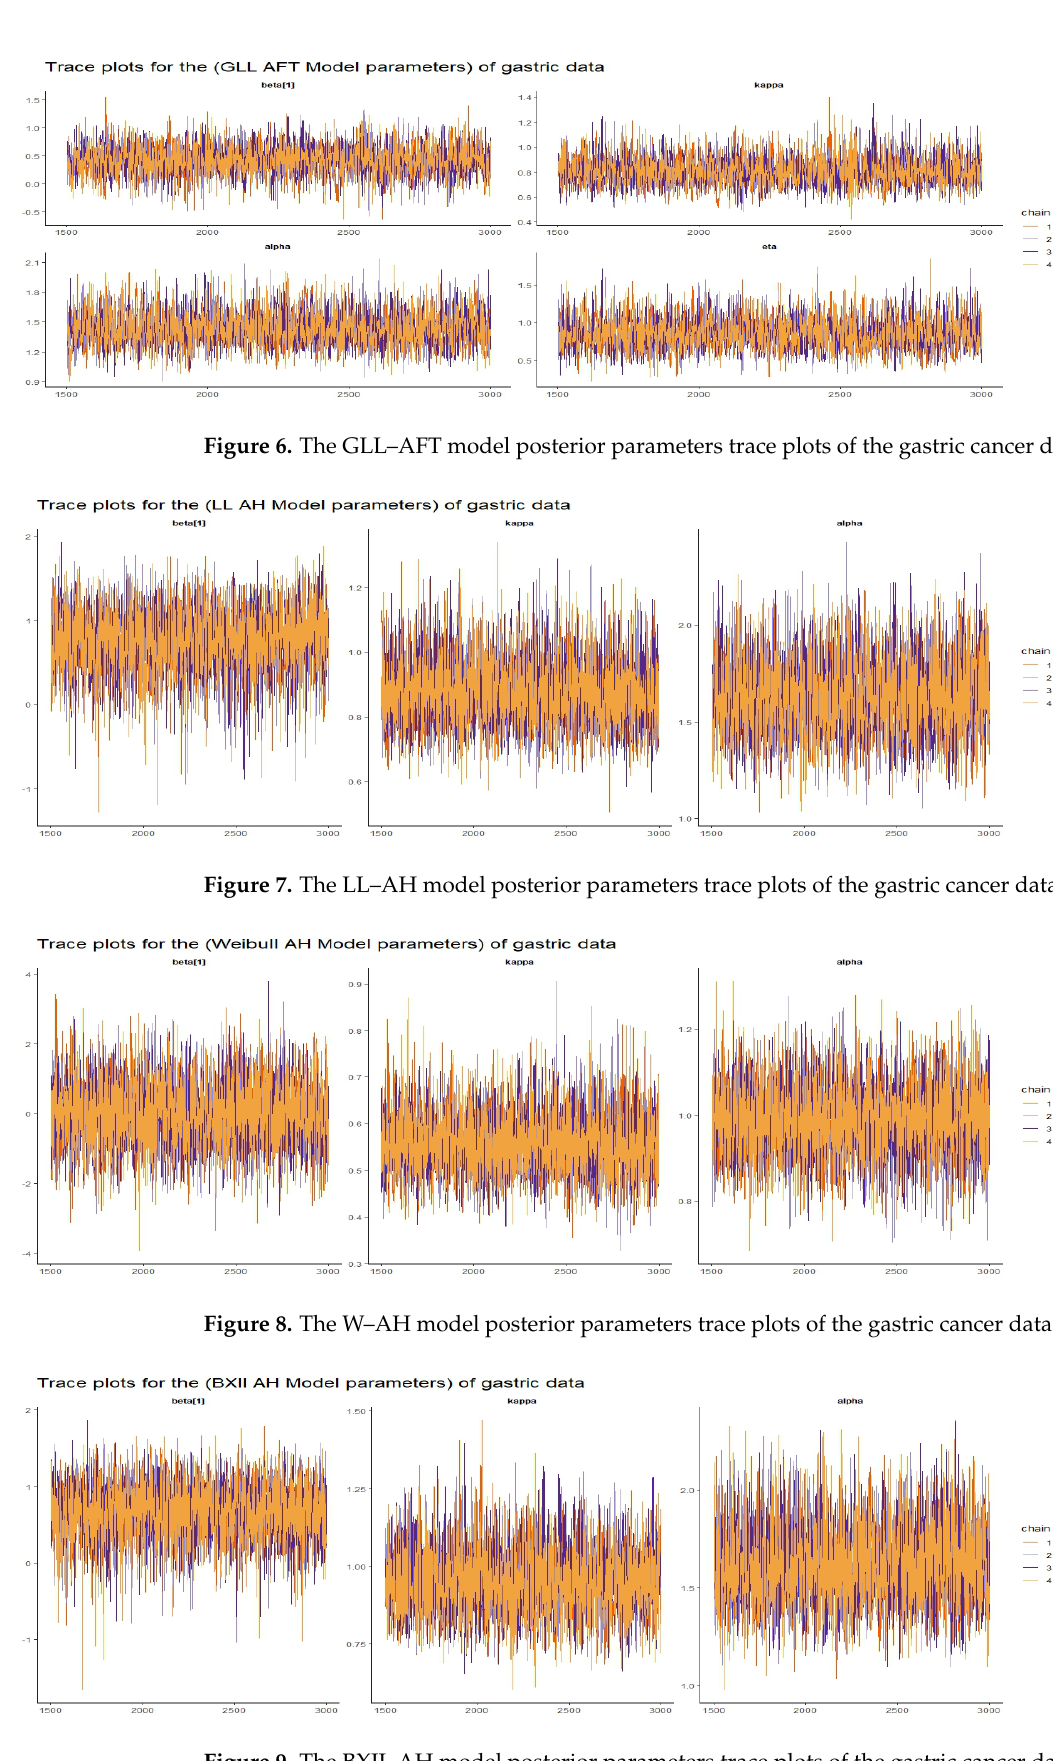
Figure 9. The BXII–AH model posterior parameters trace plots of the gastric cancer